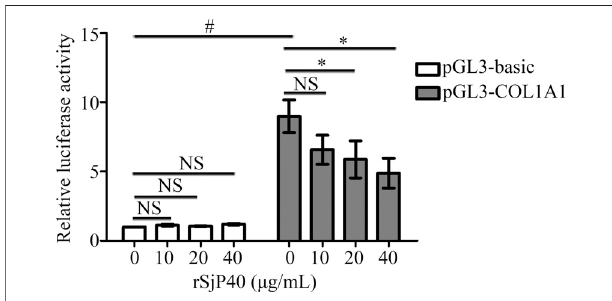
FIGURE1| rSjP40inhibitedCOL1A1promoteractivityinLX-2cells.The activity of COL1A1 promoter in LX-2 cells transfected with pGL3-COL1A1 was obviously enhanced than the luciferase activity in LX-2 cells transfected with pGL3-basic. p < 0.05, compared to pGL3-basic+ rSjP40-group. rSjP40 could inhibit the activity of COL1A1 promoter in LX-2 cells transfected withpGL3-COL1A1.However,rSjP40couldnotaffecttheluciferaseactivityin LX-2 cells transfected with pGL3-basic. p < 0.05, compared to pGL3- COL1A1+ rSjP40-group. NSP > 0.05, compared to pGL3-COL1A1+ rSjP40-